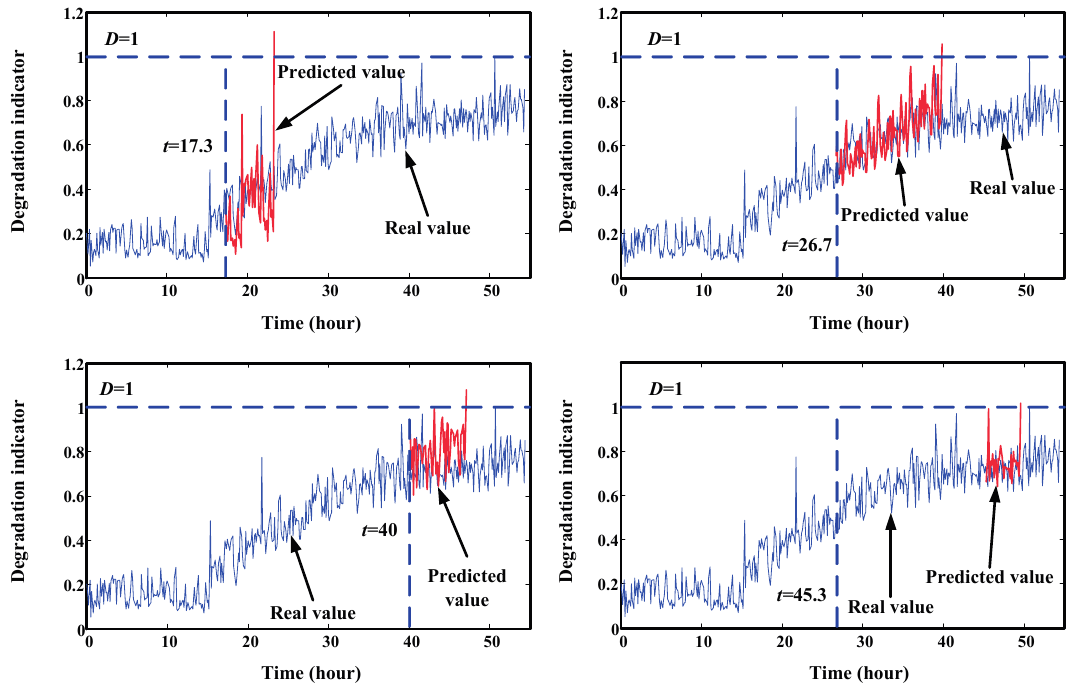
Figure 21. Trend prediction results of degradation data of gearbox. ( a ) prediction results at start time 17.3 h; ( b ) prediction results at start time 26.7 h; ( c ) prediction results at start time 40 h; ( d ) prediction results at start time 45.3